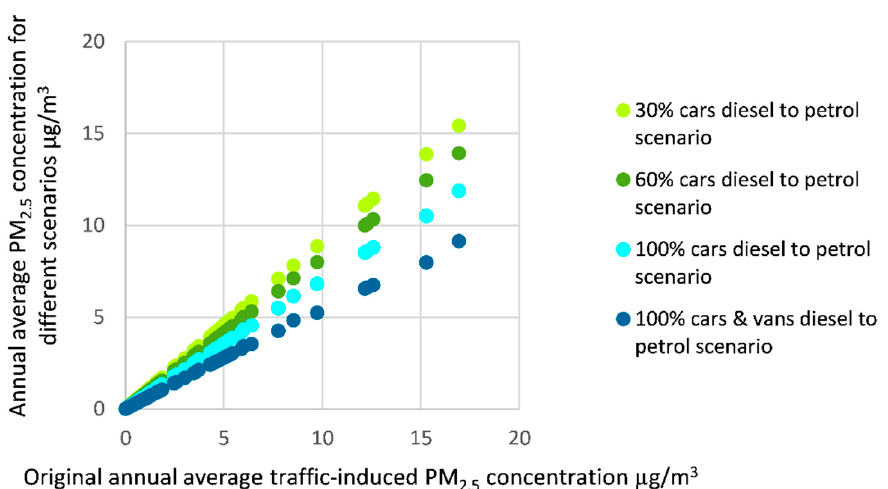
Figure A2. Predicted change in PM 2.5 traffic induced concentrations on each road segment in the model domain for varying fleet compositions.